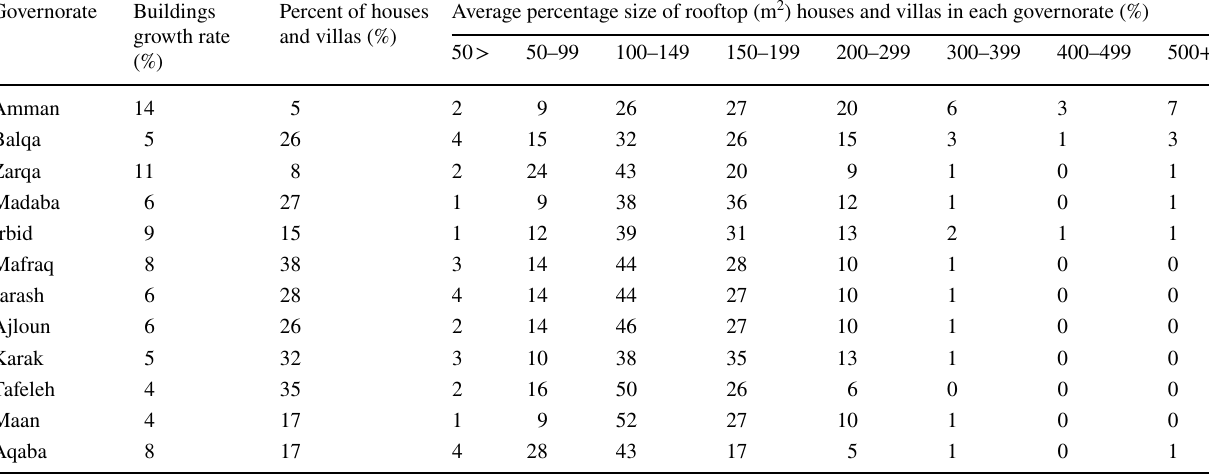
Table 1 Growth rate and percentages of houses and villas with average size of rooftop (m 2 ) in each governorate